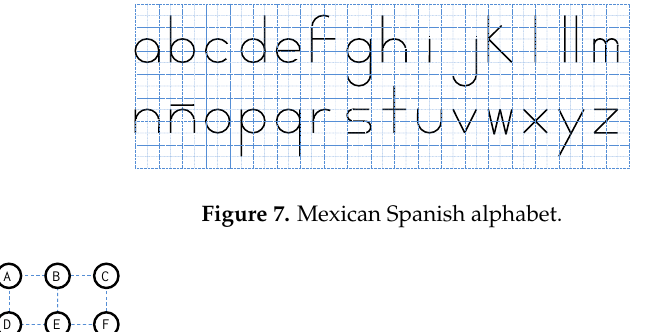
Figure 6. Reachable x-y coordinates for all θ 1 and θ 2 combinations using forward kinematics equations.